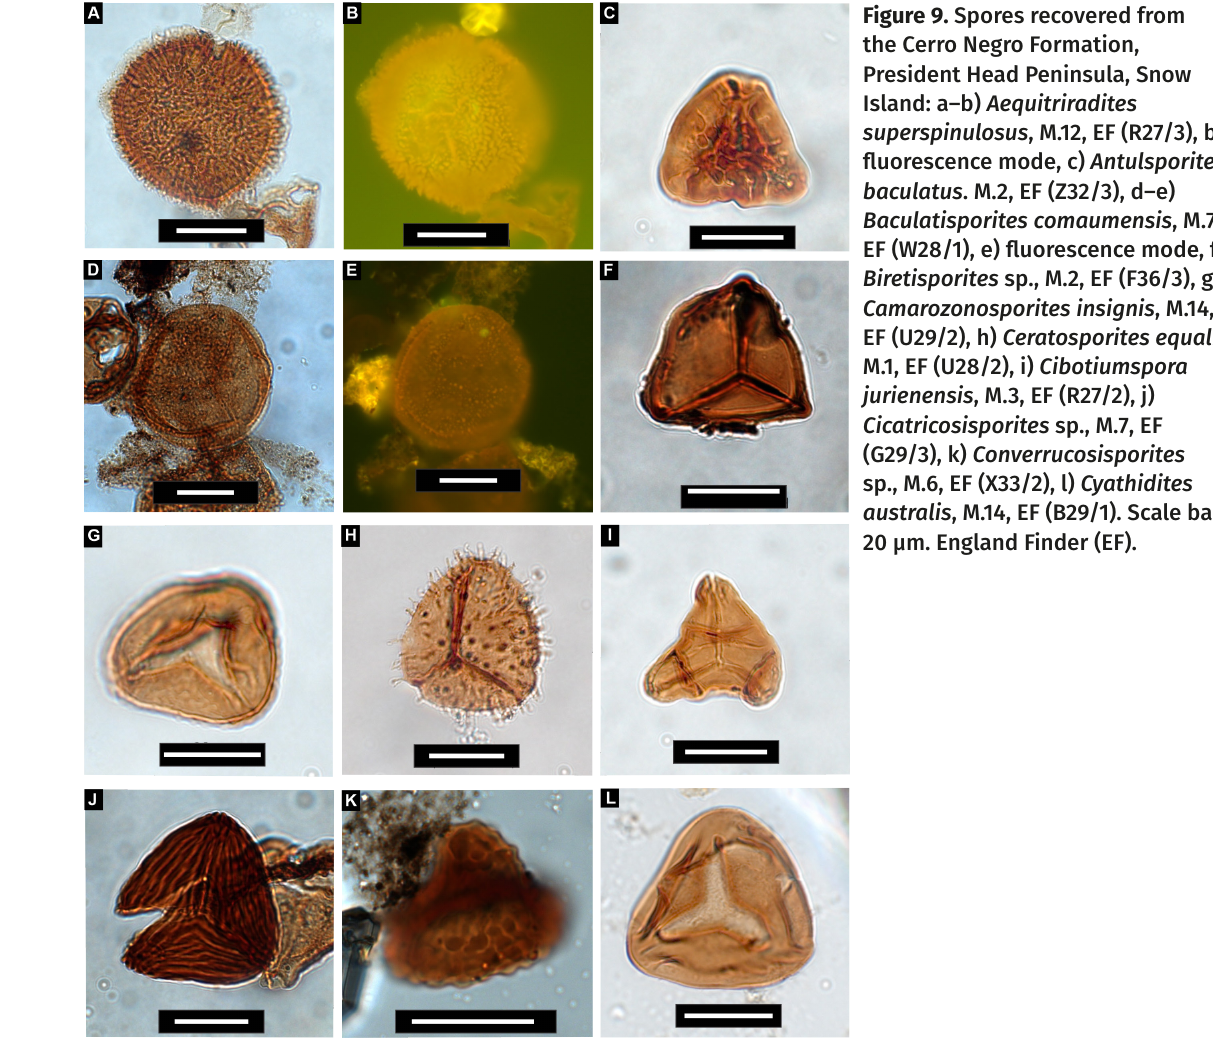
Figure 9. Spores recovered